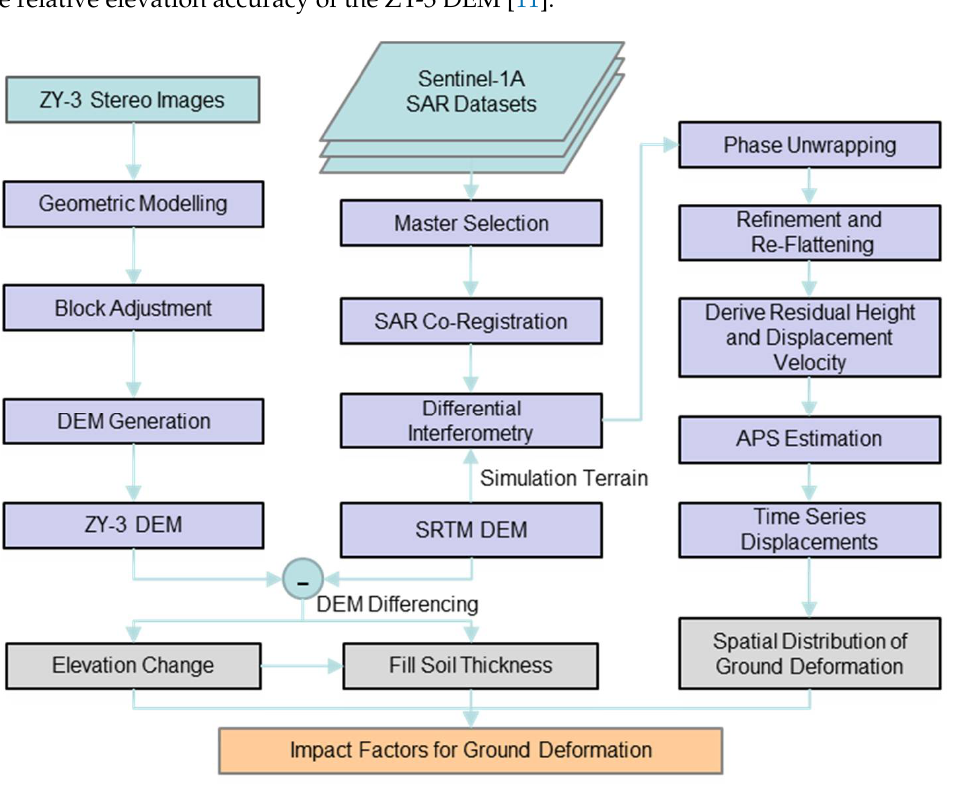
Figure 3. The methodology flowchart.